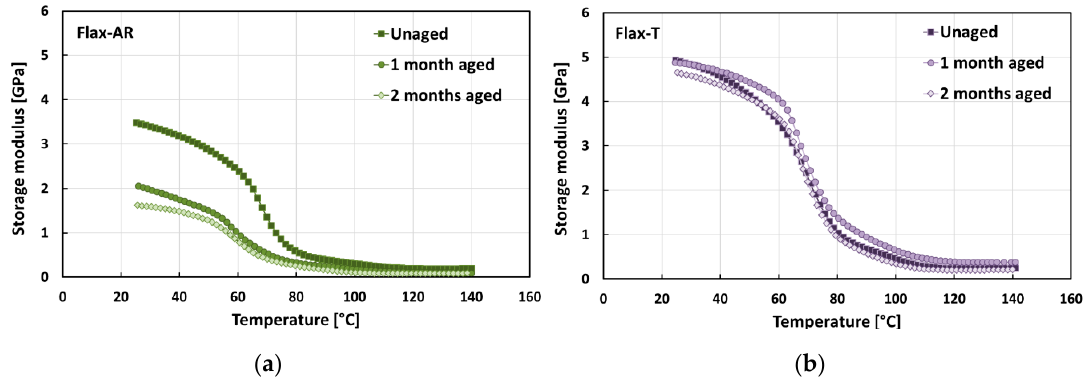
Figure 1. Typical storage modulus trends of flax composites in each aging condition: ( a ) Flax ‐ AR composites; ( b ) Flax ‐ T composites.